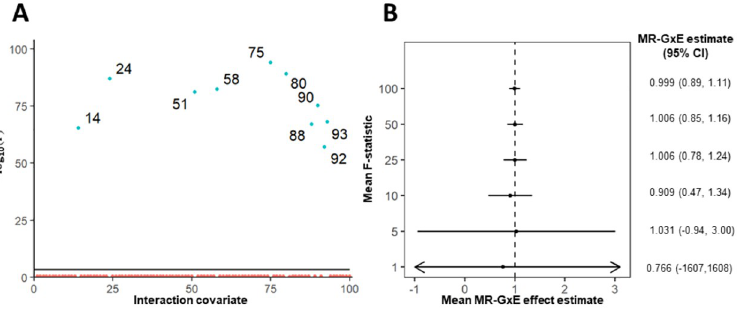
across the set of 100 potential interaction covariates in simulation 1. A solid horizontal line is included representing the Bonferroni correction threshold for statistical significance in panel A. Panel B shows a forest plot of mean causal effect estimates and confidence intervals under varying mean interaction strengths in simulation 2. The dotted vertical line in panel B represents the true causal effect β 1 = 1, and arrows are used to indicate confidence intervals exceeding the limits of the forest